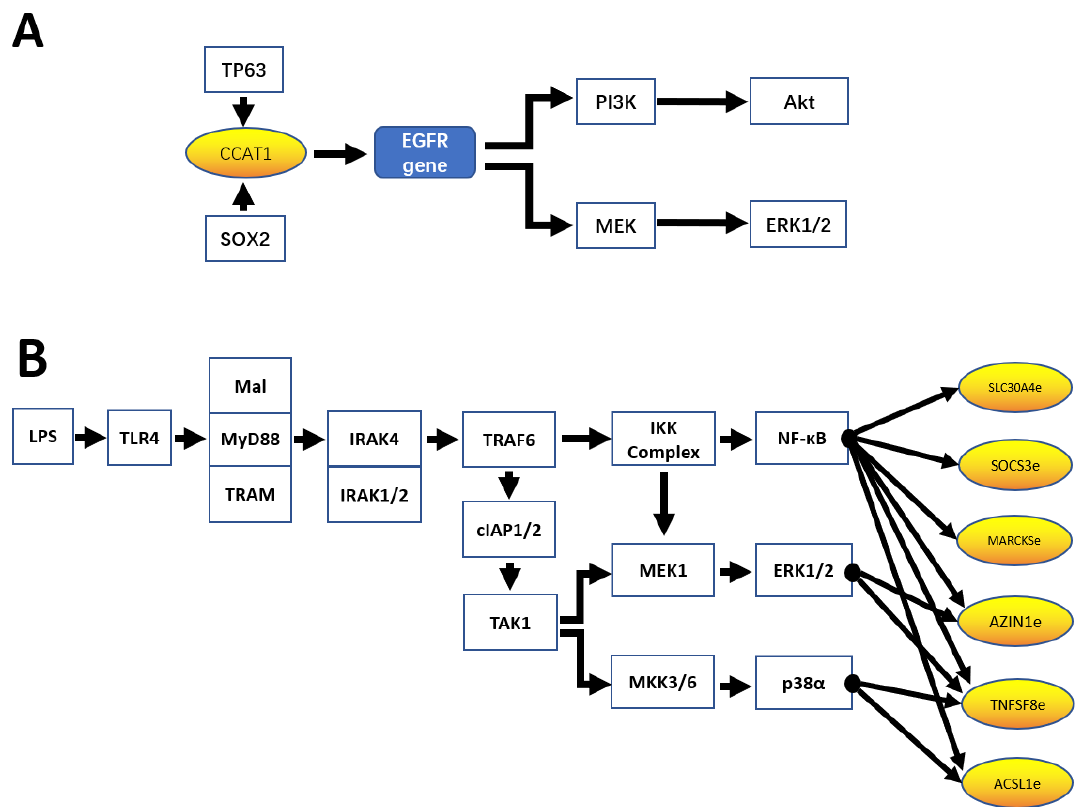
Figure 2. Pathways regulated by eRNA and pathways regulating eRNA expression. ( A ) eRNA CCAT1 activates PI3K/AKT and MEK/ERK1/2 signaling pathways. ( B ) Expression of LPS-induced eRNAs is regulated by divergent signaling path- ways.